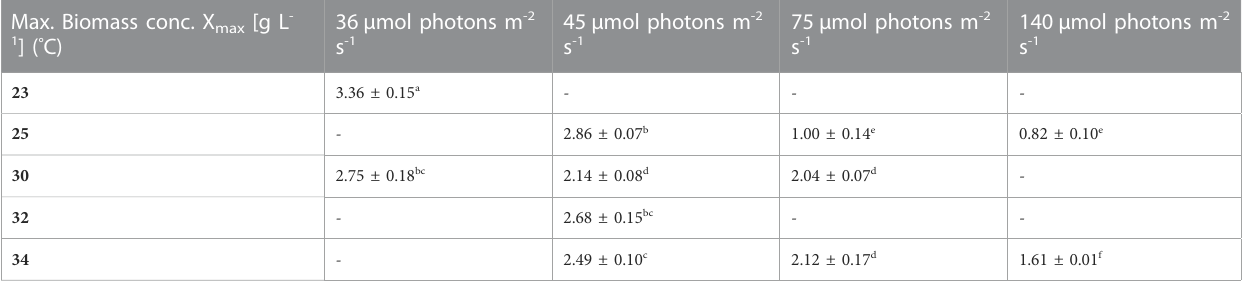
TABLE 3 Maximum biomass concentration (X max ) obtained at the end of the batch under the different conditions. The values are shown as mean ± SD of four to eight cultures. Max. Biomass conc. X max [g L - 1 ] ( ° C)